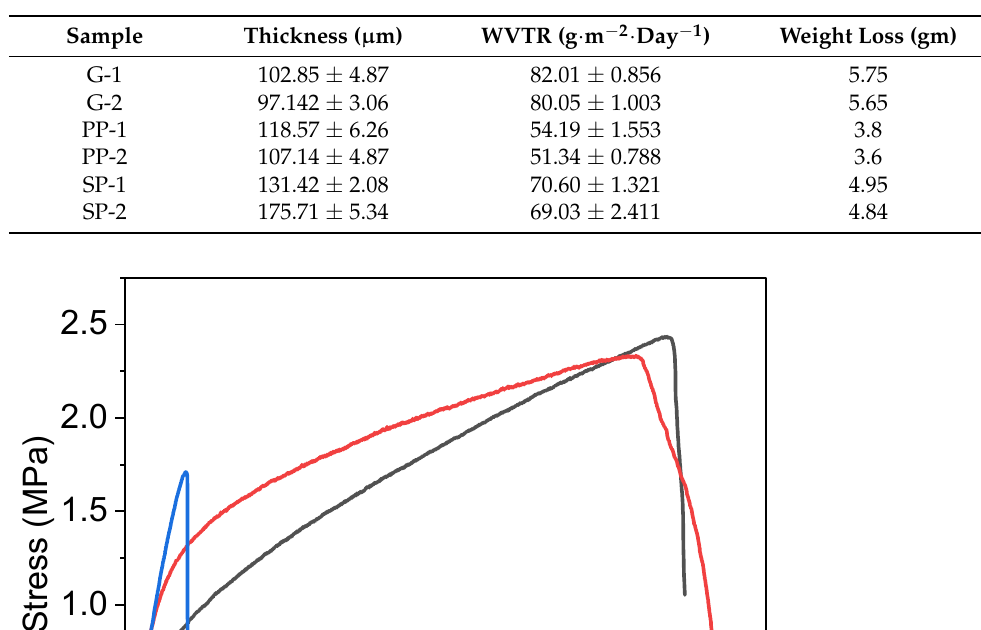
Table 4. Barrier properties of edible film.